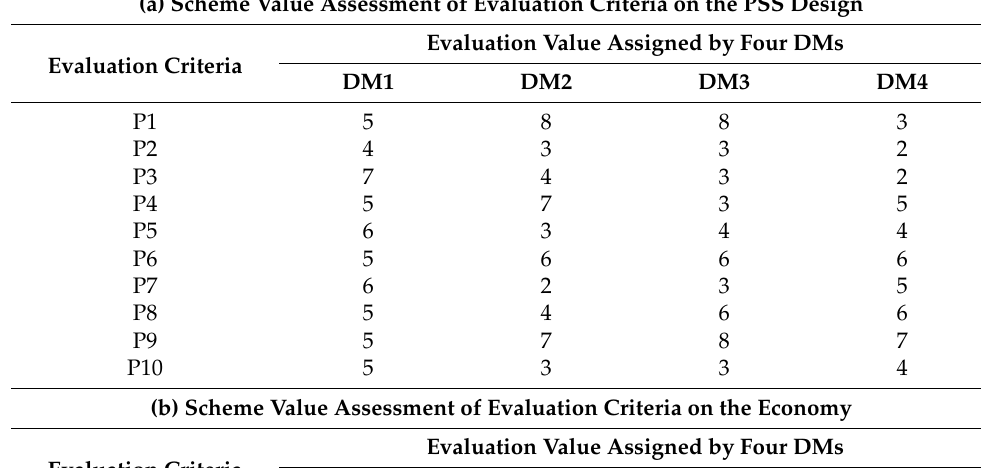
Table A4. Initial evaluation matrix of the electric forklift PSS concept (taking the CS4 as an example). (a) Scheme Value Assessment of Evaluation Criteria on the PSS Design Evaluation Criteria